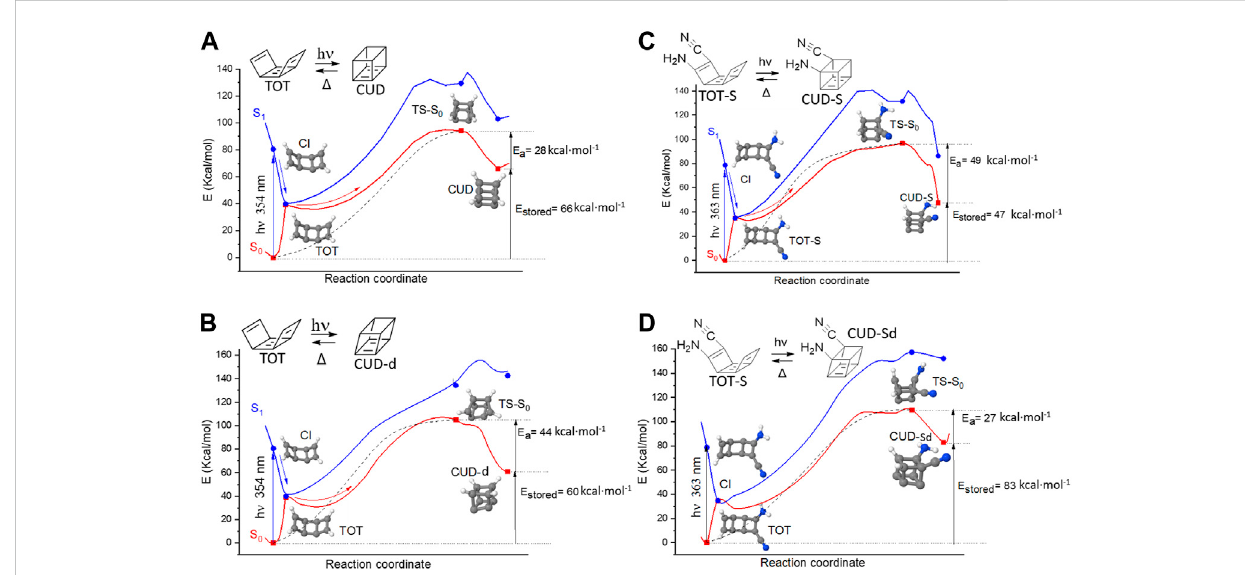
FIGURE 7 Photoproduction of (A) CUD and (B) distorted CUD from TOT and photoproduction of (C) the substituted CUD and (D) substituted and distorted CUDfromthesubstitutedTOT.Theground-statereversionpathtoTOT (A,B) andTOT-S (C,D) isalsodepictedbyadottedline.Allminimumenergypaths show CASSCF energetics and the structures of minima, conical intersections (CI), and S 0 transition states (TS).